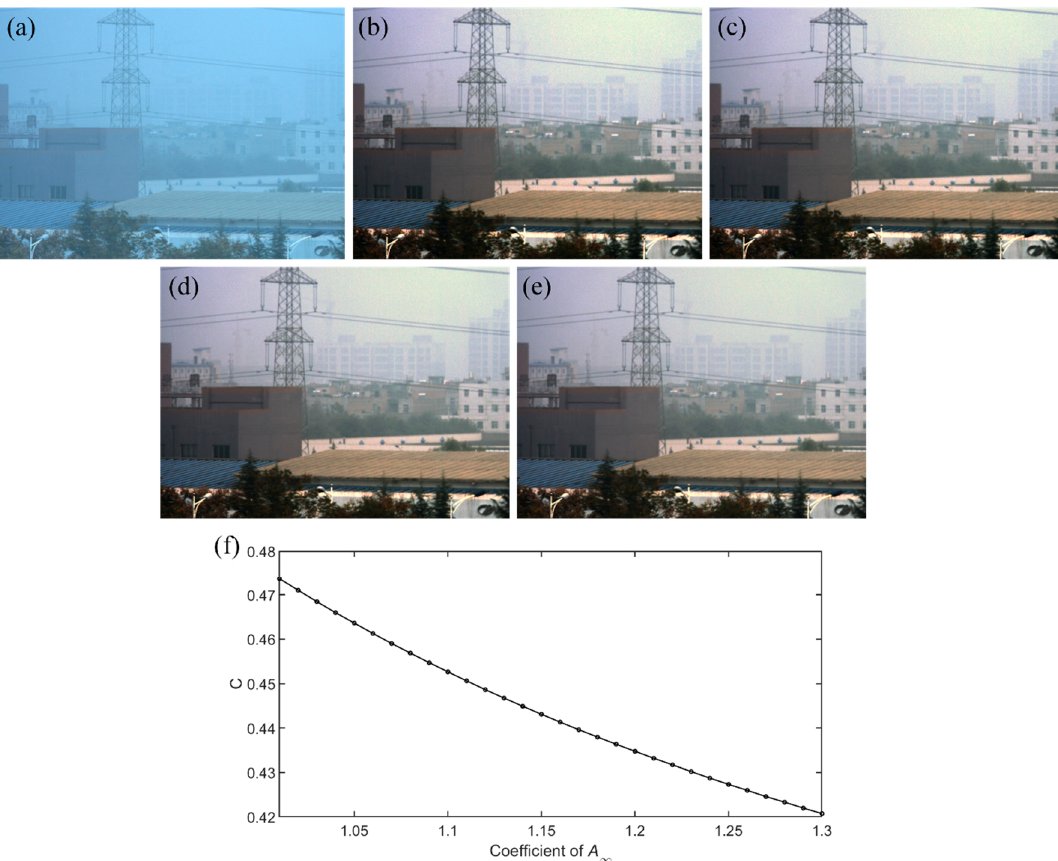
Figure 9. Experimental results with different coefficients of A ∞ . ( a ) Original intensity image; ( b )–( e ) dehazed images with the coefficient of 1.01, 1.05, 1.2 and 1.3, respectively; and ( f ) the relationship between the contrast (C) and the coefficient of A ∞ .